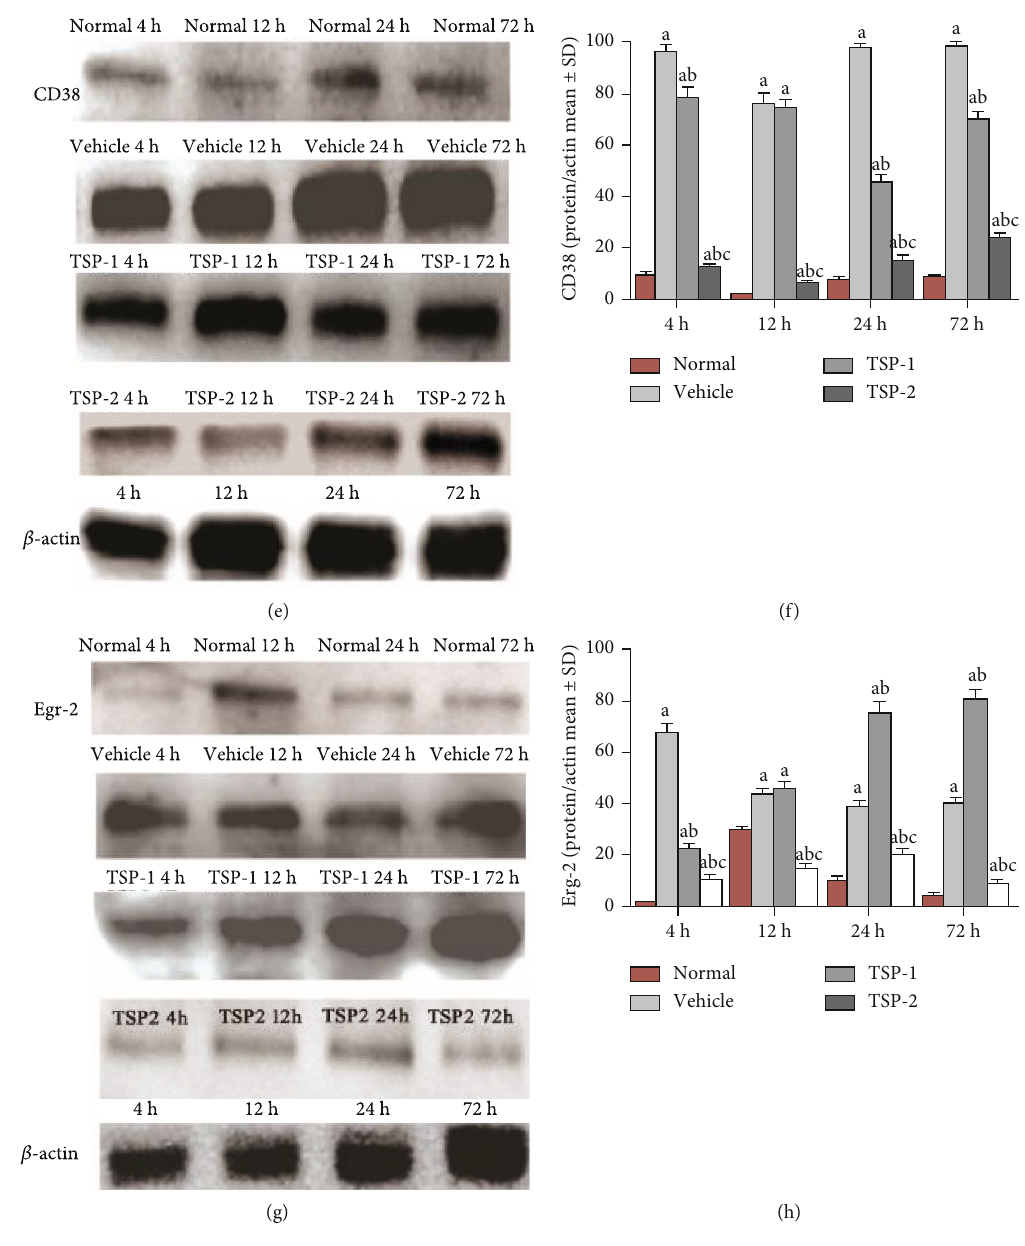
Figure 9: E ff ect of TSP overexpression on macrophage polarization in vivo . Mouse protein lysates from normal mice or mice treated with LPS for 4, 12, 24, and 72 h and overexpressing either empty vector (vehicle group), TSP-1 (TSP-1 group), or TSP-2 (TSP-2 group) were analyzed for expression of M2 (Agr-1 and Egr-2) (a, c) and M1 (CD38 and Fpr-2) (e, g) macrophage markers using Western blot analysis. β -Actin expression served as the loading control. The bar graphs in (b, d, f, and h) show the expression of these markers normalized to β -actin. The percentage of detected protein/actin is shown as mean ± SD . P value of < 0.05 represents signi fi cant di ff erence. a P < 0 : 05 compared with normal control; b P < 0 : 05 compared with vehicle group; c P < 0 : 05 compared with TSP-1 transfected group ( n = 4 per